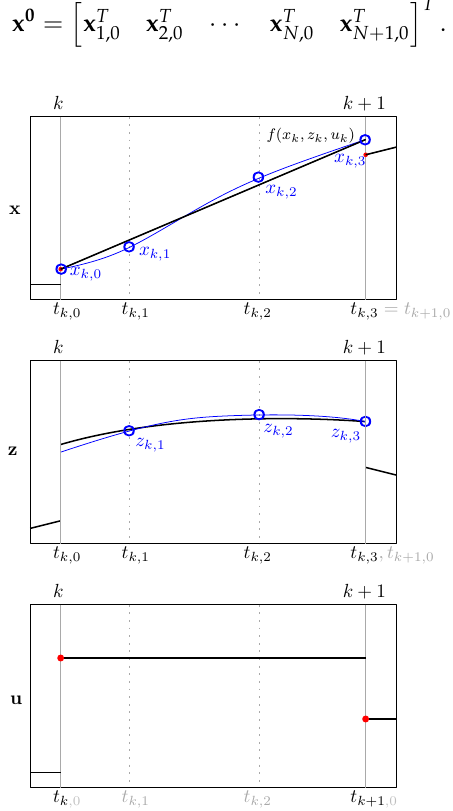
Figure 2. Schematic representation of third order direct collocation using Radau scheme showing the polynomial approximation of dynamic system (8) for a single sampling interval [ k , k + 1 ] . Note that the differential state has one additional collocation point at t k ,0 , which is used to ensure state continuity by enforcing shooting gap constraints. The control input u is piecewise constant over the interval [ k , k + 1 ]